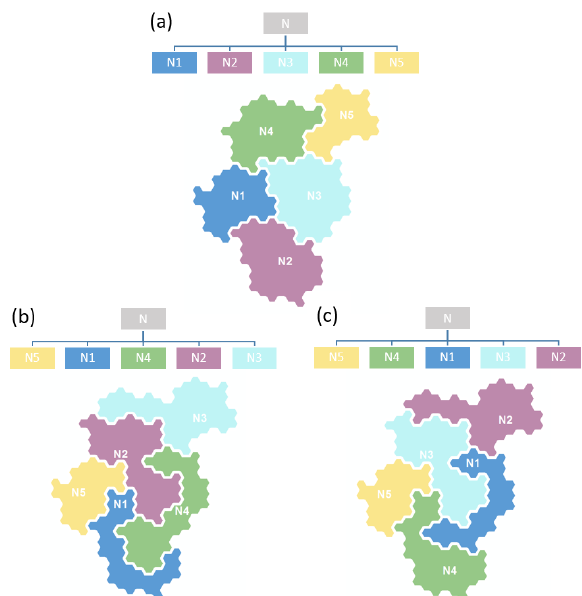
Figure 5. The different map regional layouts corresponding to different node sequences: ( a ) Map layout corresponding to node sequence “N1N2N3N4N5”; ( b ) Map layout corresponding to node sequence “N5N1N4N2N3”; ( c ) Map layout corresponding to node sequence “N5N4N1N3N2”.